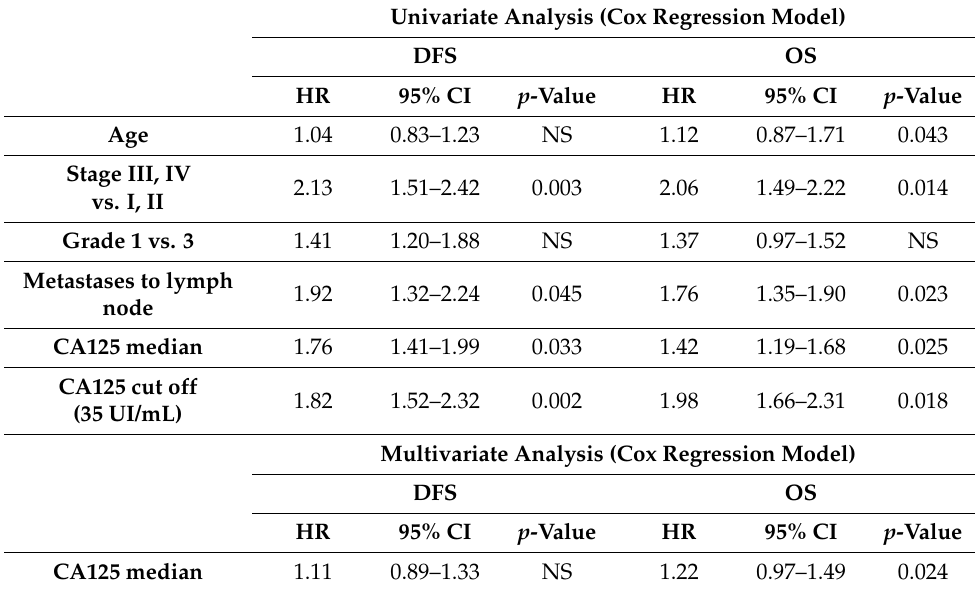
Table 6. Cox regression analyses of the disease-free survival and overall survival of classic prognostic factors and